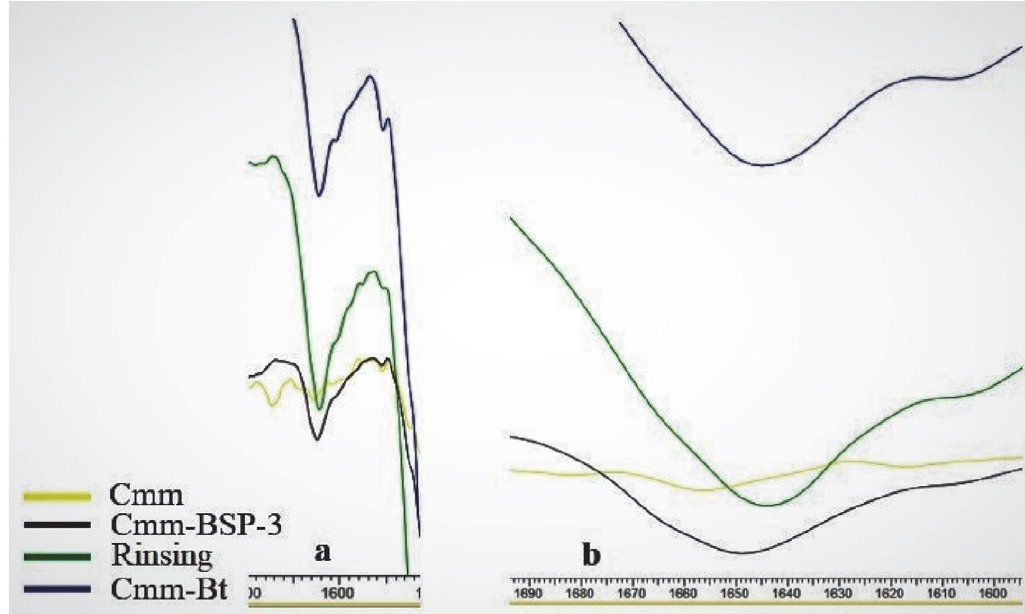
Figure 6. a. Vertical zoomed FTIR bands, b. horizontal zoomed FTIR bands. BSP-3 chemosensor emits the signal due to non-complementary